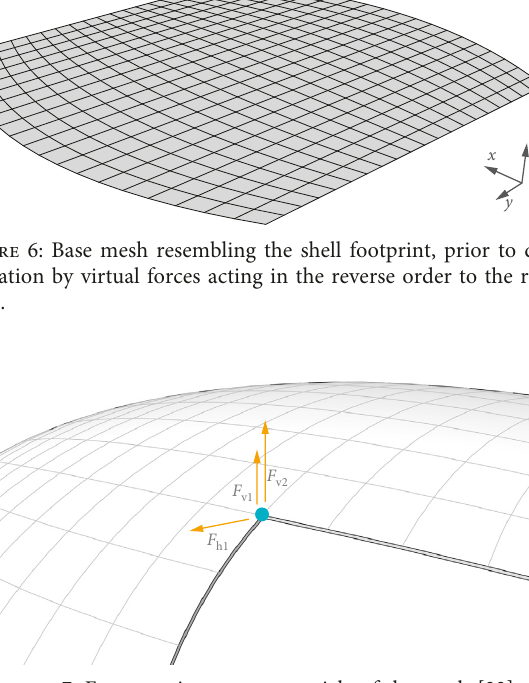
Figure 7: Forces acting on one particle of the mesh [23].